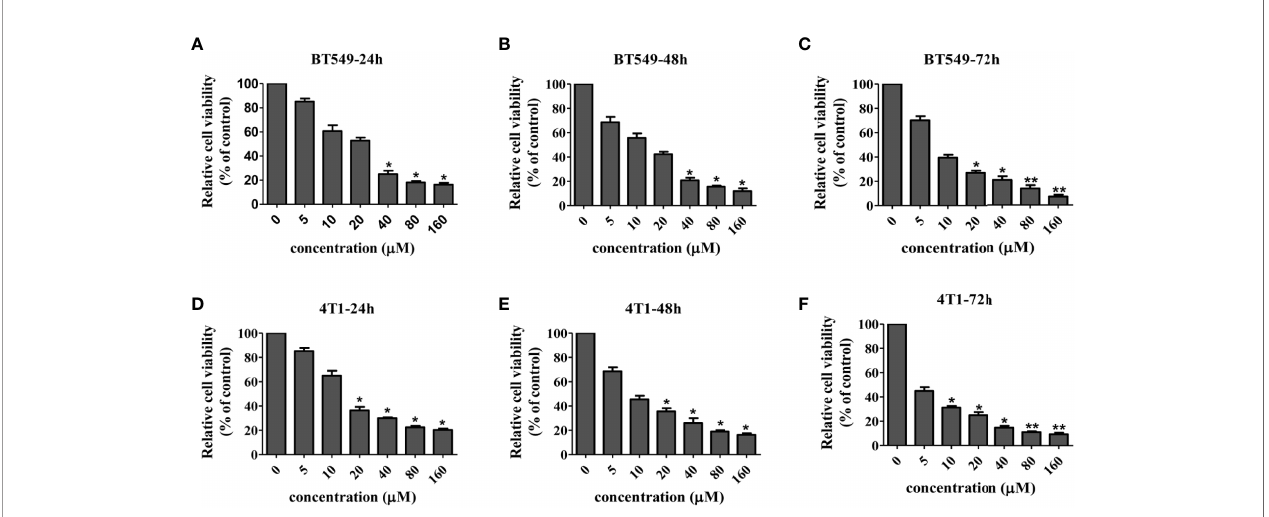
FIGURE 1 | Cellular toxicity of cordycepin. Cancer cells were treated with different concentrations of CD for 24/48/72h, and MTT assay was performed. BT549 cells were treated with different concentrations of CD for 24h/48h/72h (A – C) . 4T1 cells were treated with different concentrations of CD for 24h/48/72h (D – F) . Results are presented as mean±SD, which shows that CD dose dependently decreases the cell viability. *P<0.05, **P<0.01